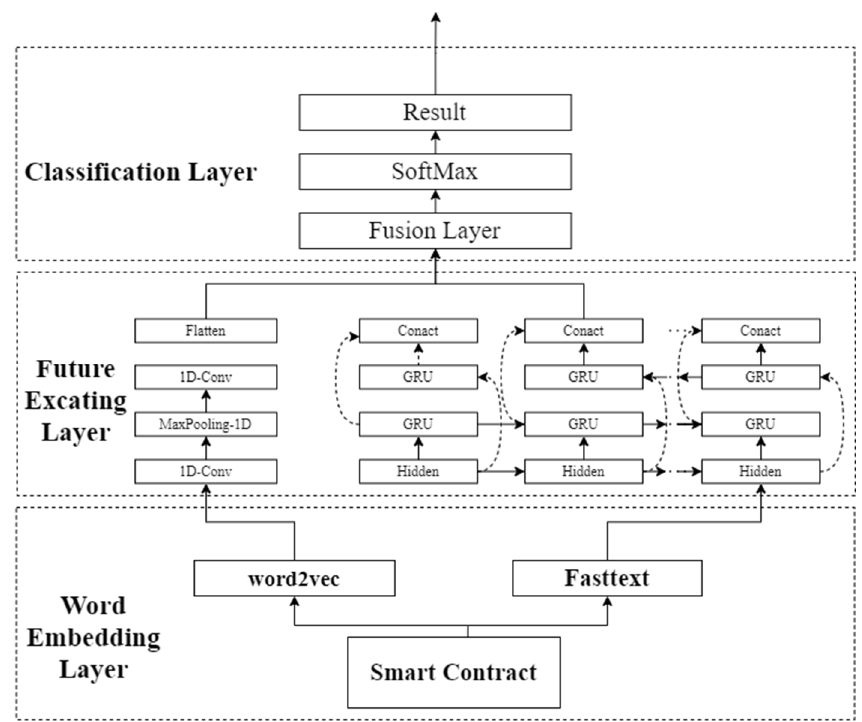
Figure 5. CBGRU hybrid model structure.